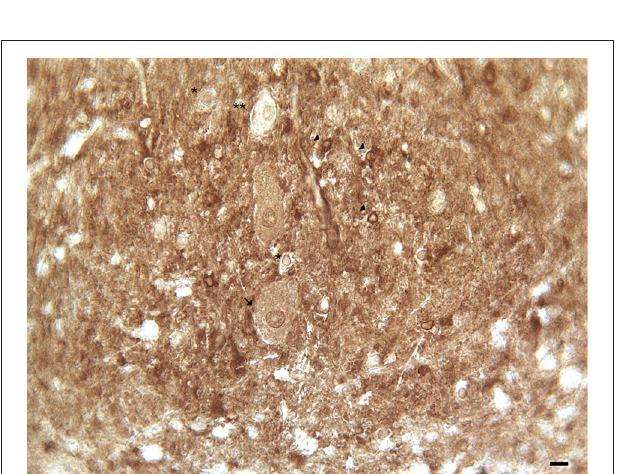
of Held, the sites of the cerebellar glomeruli ( Table 1 ; Figure 1